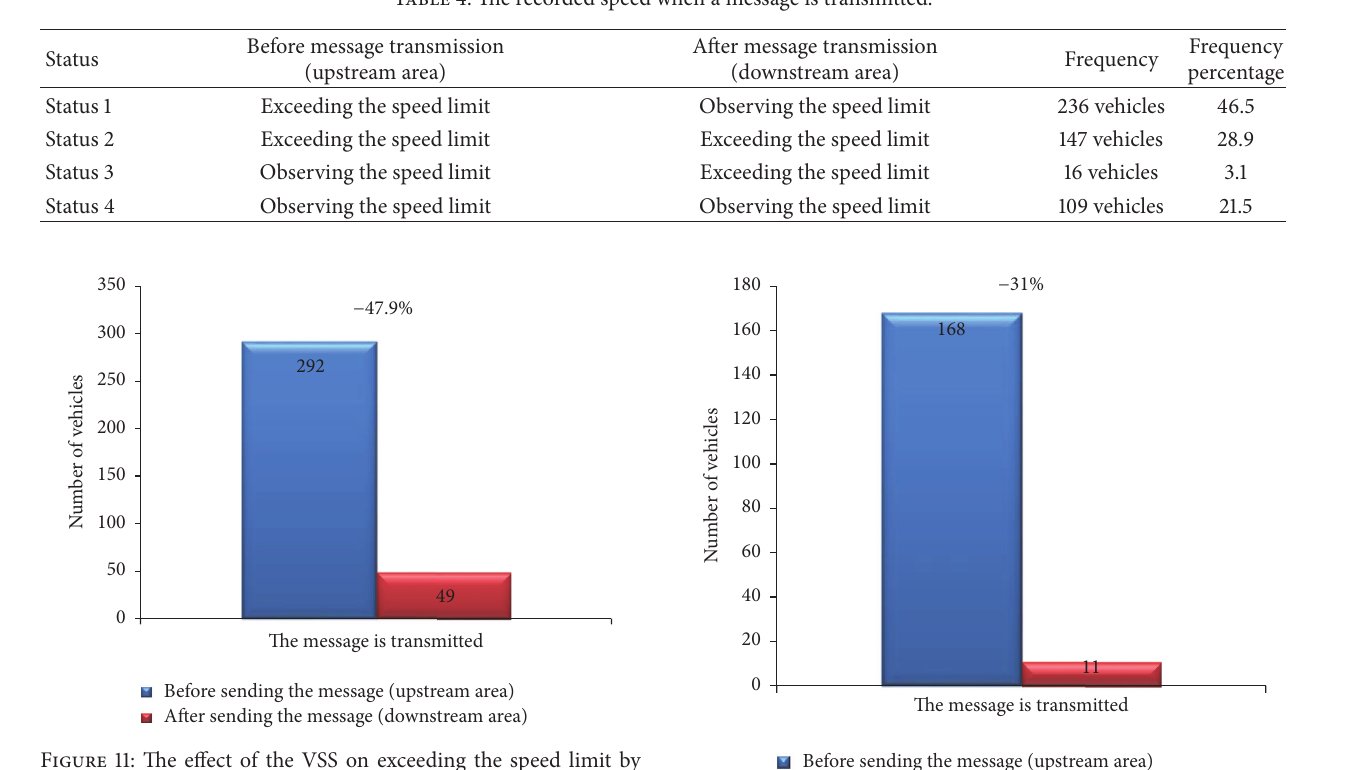
Table 4: The recorded speed when a message is transmitted.